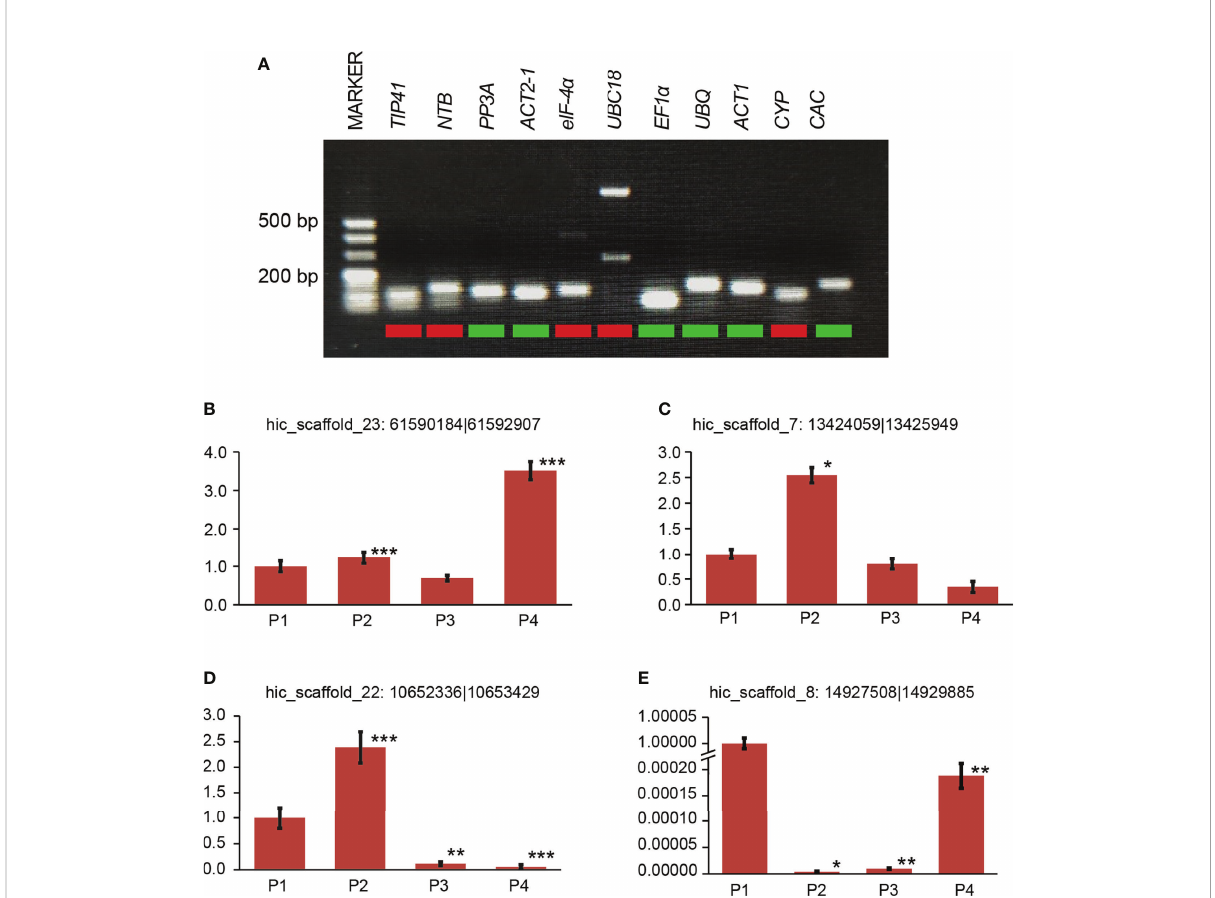
FIGURE 3 Reference gene selection and qRT-PCR validation of four DE circRNAs (A) PCR ampli fi cation of 11 reference genes. (B-E) Relative expression offour selected DE circRNAs measured by RT-qPCR. For RT-qPCR, three replicates were performed. Asterisks on bars indicate signi fi cant differences between different stages using a t -test. Error bars represent the standard error of the mean. Drought treatment: 0 day (P1), 2 days of drought treatment (P2), 4 days of drought treatment (P3) and 6 days of drought treatment (P4). * p < 0.05, indicates a signi fi cant difference. ** p <